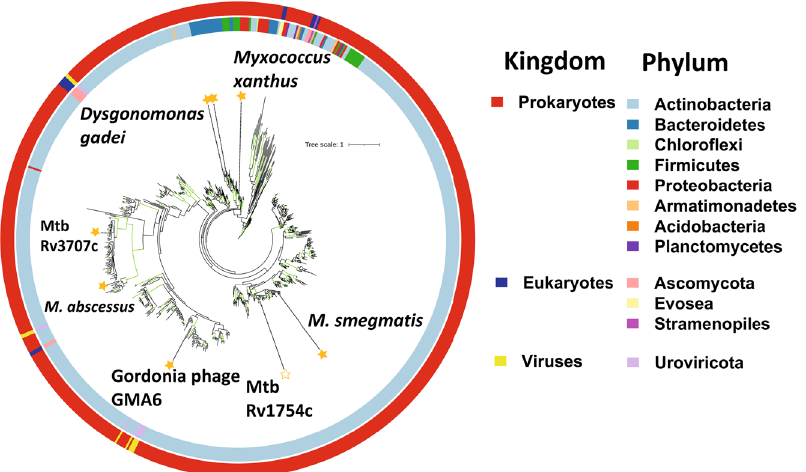
substitutions per amino acid residue. Colored rings indicate phylum (inner) and kingdom(outer)taxonomyinformationforsequences.Starshighlightsequencesof